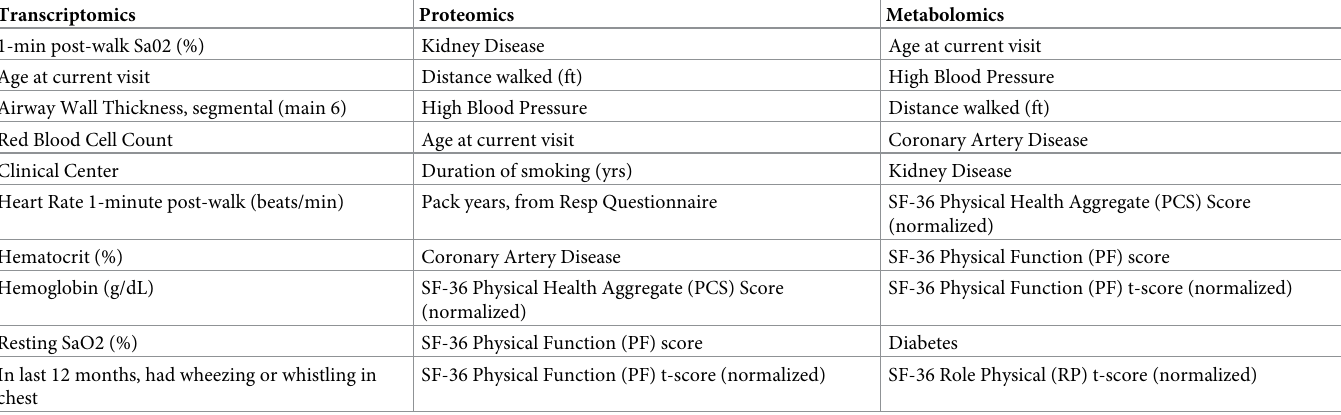
Table 3. Summary of top 10 single-omics clinical associations. All clinical variables listed were significant at a false discovery rate of 10% over the variables tested and are ordered by significance. Only the top 10 associations are displayed. For more details see Data Dictionary in S3 Table and complete results in S5 Table